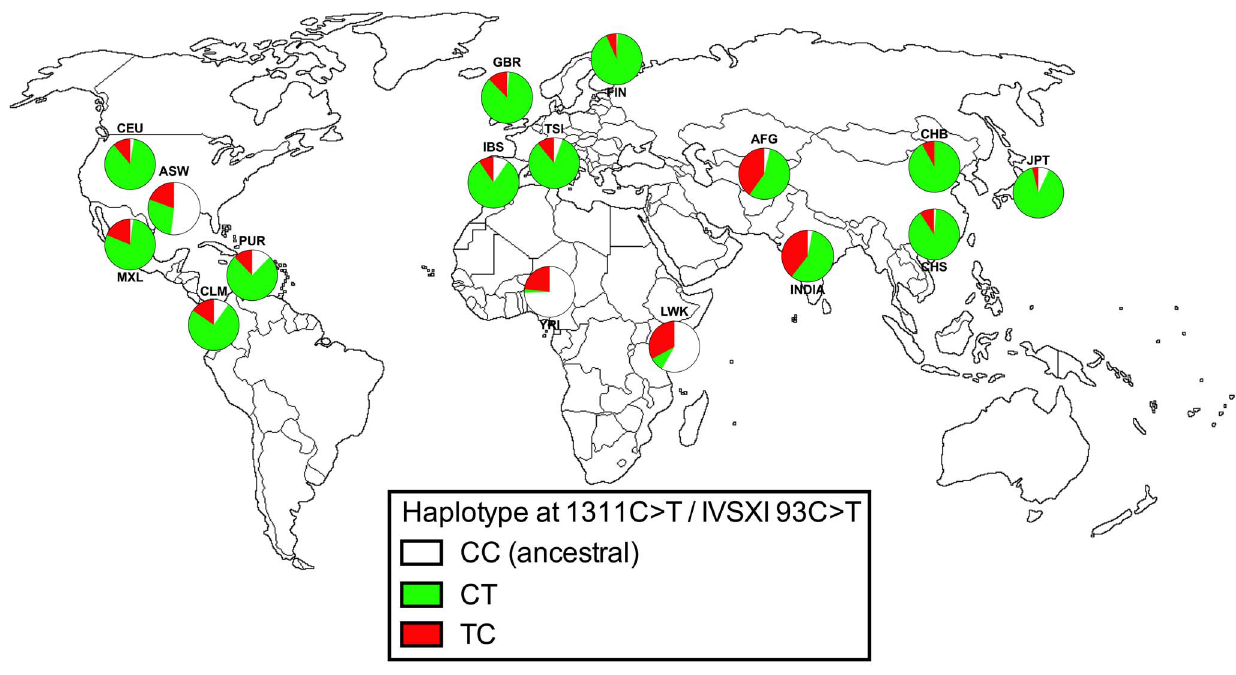
Figure 2. Haplotypes of 1311C . T and IVSXI C93T in G6PD-normal individuals. Data are expressed as total chromosomes and are derived from the 1000 genomes project [23], one published dataset from India [24](INDIA) and this study (AFG). Population abbreviations: ASW, people with African ancestry in Southwest United States; CEU, Utah residents with ancestry from Northern and Western Europe; CHB, Han Chinese in Beijing, China; CHS, Han Chinese South, China; CLM, Colombians in Medellin, Colombia; FIN, Finnish in Finland; GBR, British from England and Scotland, UK; IBS, Iberian populations in Spain; LWK, Luhya in Webuye, Kenya; JPT, Japanese in Tokyo, Japan; MXL, people with Mexican ancestry in Los Angeles, California; PUR, Puerto Ricans in Puerto Rico; TSI, Toscani in Italia; YRI, Yoruba in Ibadan, Nigeria.